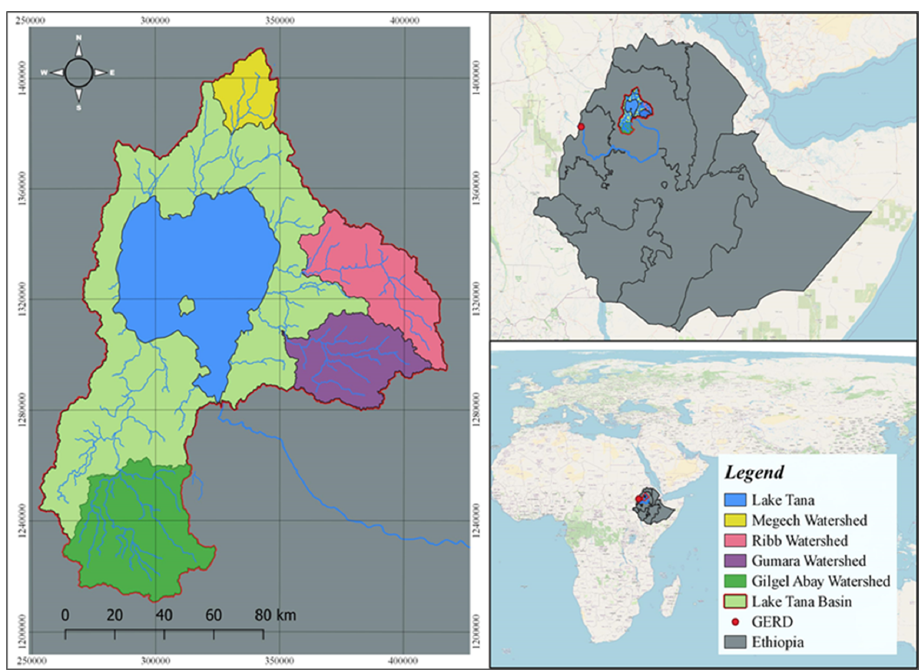
Figure 1. Geographical location of Lake Tana basin .